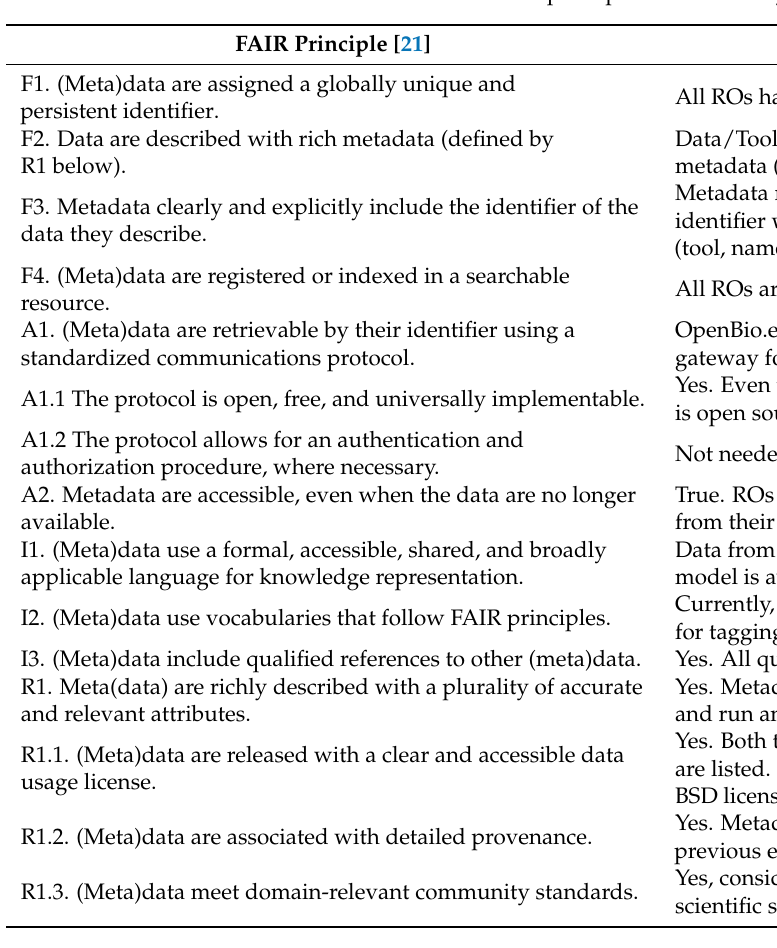
Table 1. List of all official FAIR principles and how they are addressed in